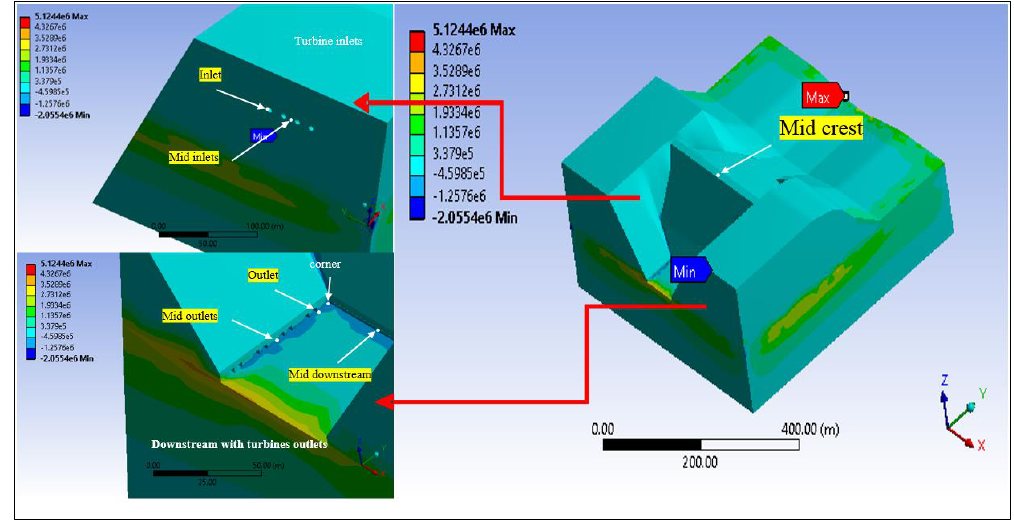
Figure 13. The principle stress distribution on the dam-reservoir-foundation system in minimum water level with operating 4 turbine units.